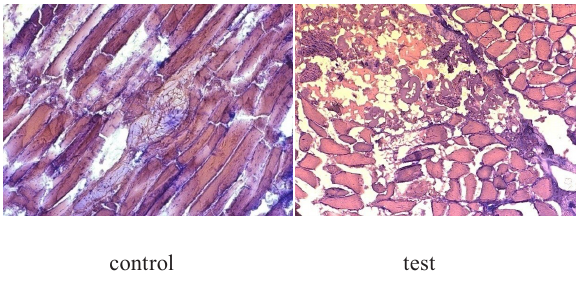
Figure 6 Microstructure of restructured poultry